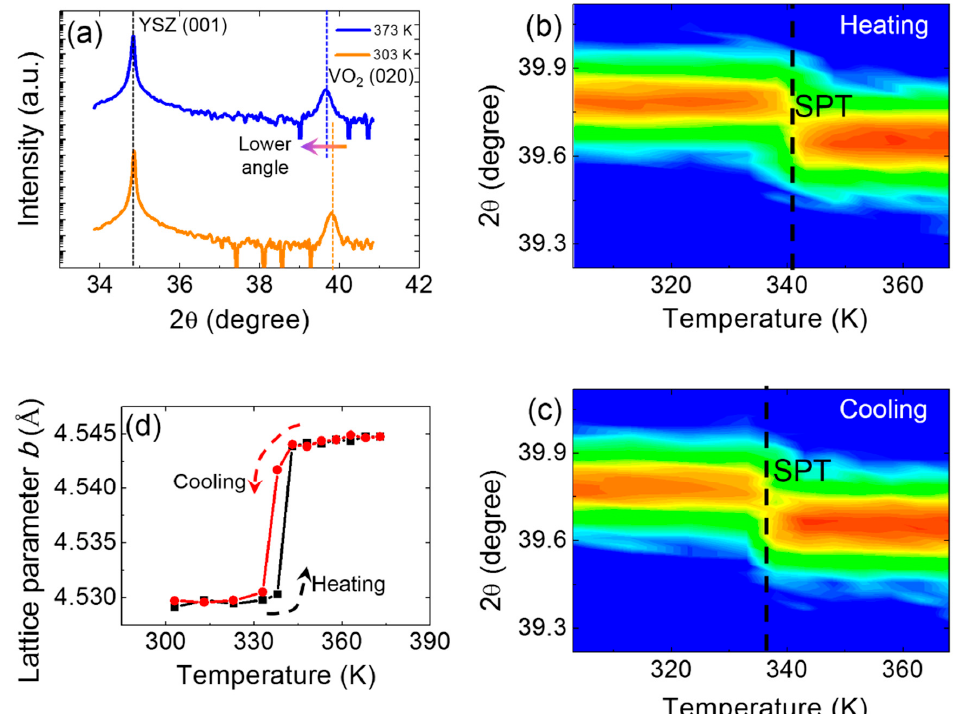
Figure 4. The structural phase transition studied by XRD. ( a ) The local XRD θ –2 θ scans of the VO 2 (020) peaks at 303 and 373 K. The evolutions of the VO 2 (020) peaks under increasing ( b ) and decreasing ( c ) temperatures. ( d ) The lattice constant b vs. the temperature curve.